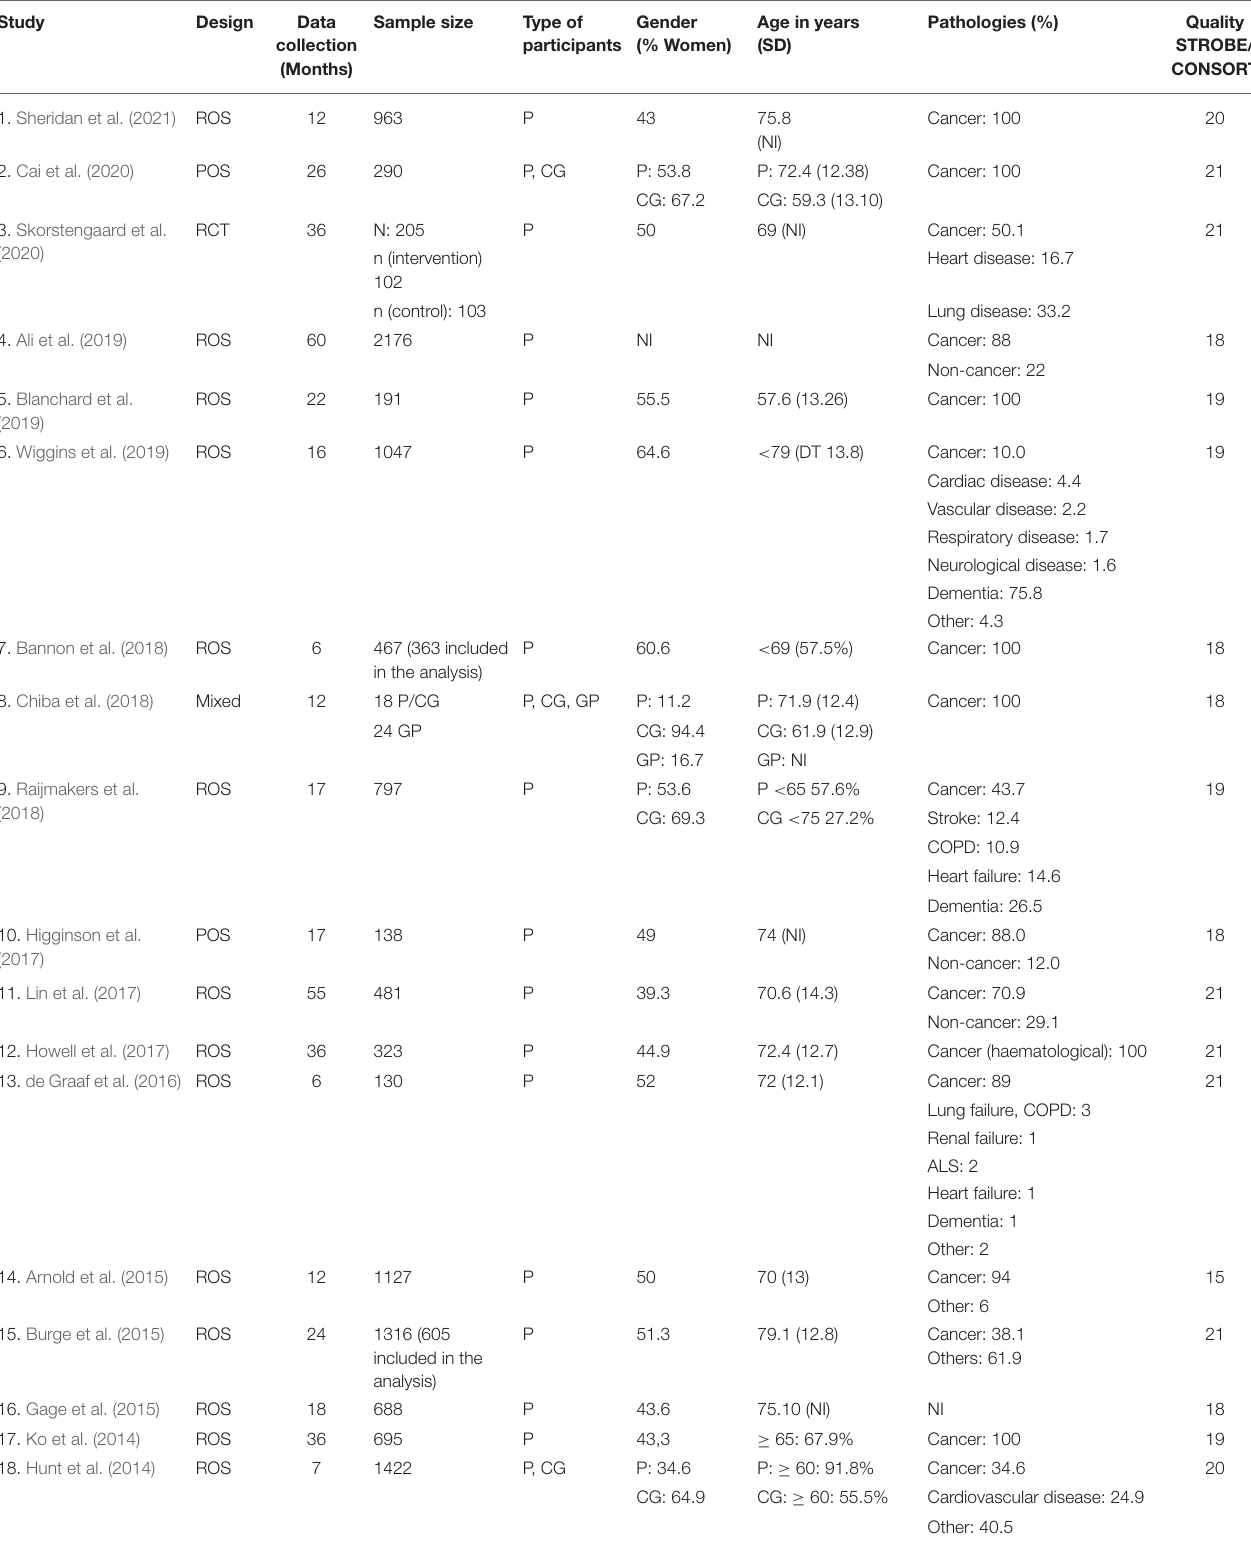
TABLE 1 | Study characteristics.